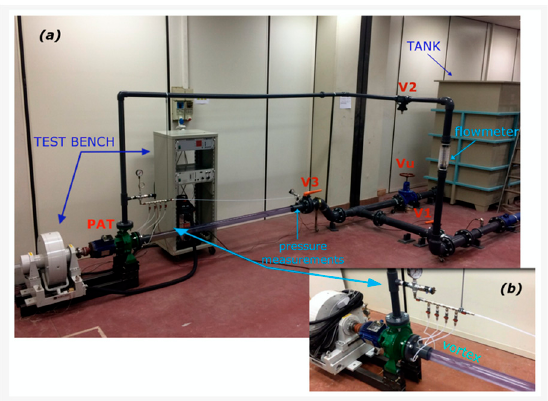
Figure 11. Test setup: ( a ) main elements of the supply system; and ( b ) vortex generation at the Pumps As Turbines (PAT) outlet [20].